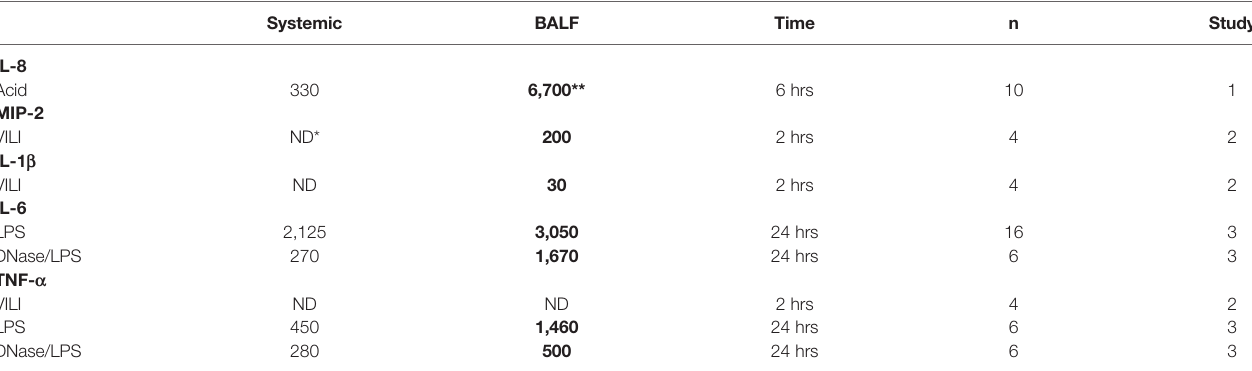
Values are means in pg/ml. The values were either given or approximated from measurements provided (transparent grid overlay). Time: time of sample collections in hours after direct insult to lungs. *ND, not detected. **Samples from distal small bronchi, presumed to represent alveolar fl uid, contained 40,500 pg/ml IL-8. Study 1 (Folkesson et al., 1995): Hydrochloric acid given intratracheally to rabbits. Indices of lung injury: lung edema and systemic hypoxia, PMN in fi ltration. All rabbits died within 12 -14 hours after lung injury. Study 2 (Ricard et al., 2001): ventilator-induced lung injury in rats (VILI; 42 ml/kg tidal volume). Index of lung injury: Increased protein levels in BALF. Study 3 (Liu et al., 2016): lipopolysaccharide (LPS) given intratracheally to mice. Indices of lung injury: interstitial edema, PMN in fi ltration, hemorrhage, NET components in BALF and lung tissue. Intratracheal DNase reduced NET formation and lung injury. Compartment with higher levels in bold font.